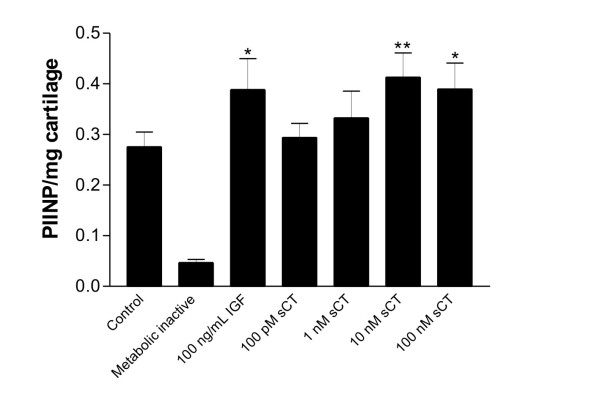
Stimulation of human OA cartiage explants with salmon caltionin increase the release of pro-peptides of type II collagen. Human OA cartilage explants were cultured for 16 days with different doses of salmon calcitonin and IGF as positiv control. The released neoepitopes in the supernatant from day 16, were quatifiened by an ELISA detecting the N-terminal collagen type II pro-peptides, PIINP. The bars represent the mean value from 6-replicates and the indivdual values were adjusted for the amount of cultured cartilage. The errorbars are the standard error of mean, SEM. The asterisk symbolize the levels of statistical difference to the vehicle control, * P < 0.05. **P < 0.01.